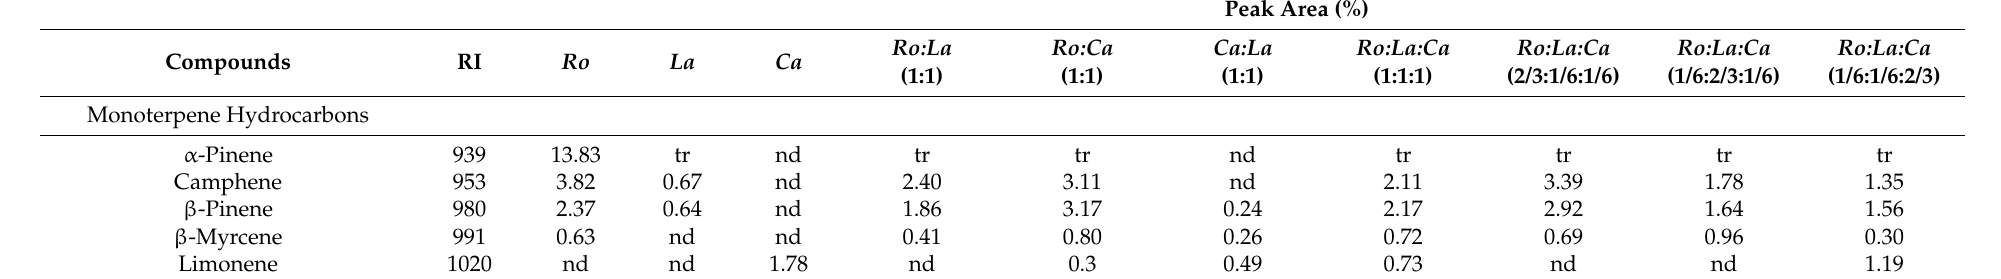
Table 2. Chemical composition in percentage of R. officinalis ( Ro ), L. angustifolia ( La ), C. aurantium ( Ca ) EOs and their combinations analyzed by GC-MS.